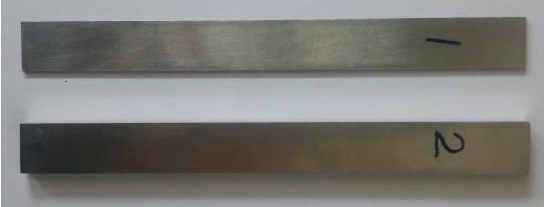
Figure 9. Waveguide bars named No. 1 and No. 2 (the thickness of No. 1 is 1 mm, and the thickness of No. 2 is 4 mm).